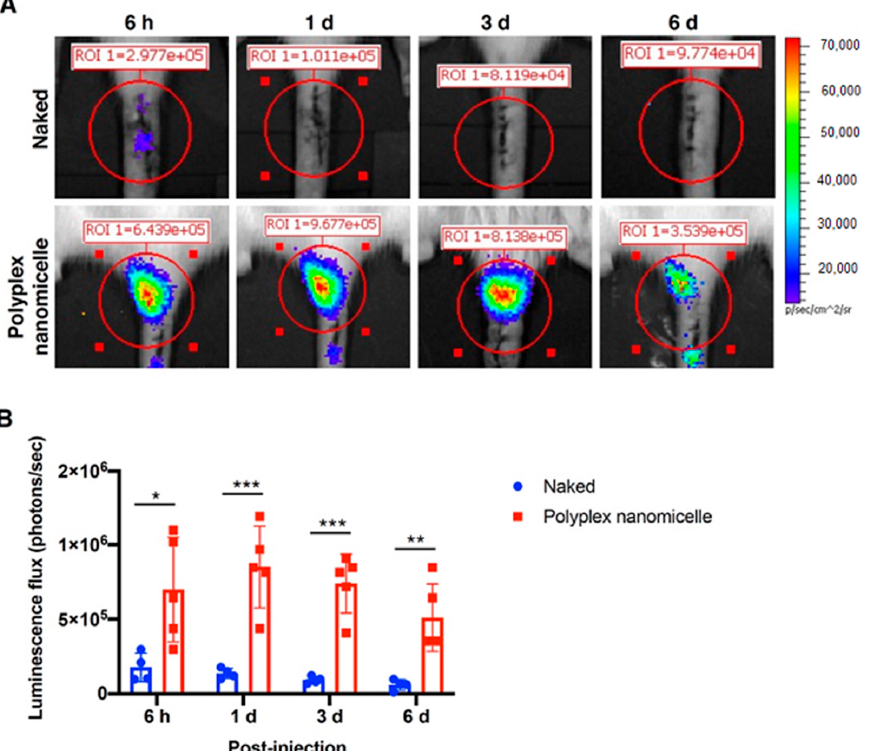
Figure 3. Luc2 mRNA delivery in the coccygeal disc defect and IVIS observations used to detect the duration of mRNA expression. ( A ) Representative images showing the luciferase expression in the coccygeal disc in rats. Luc2 mRNA was injected in naked form compared with that loaded in polyplex nanomicelle form. Images were captured by IVIS examination at 6 h to 6 days post-injection. ( B ) Quantitative analysis of luminescence emission (naked group, n = 4; polyplex nanomicelle group, n = 5). * p < 0.05, ** p < 0.01, *** p < 0.001.